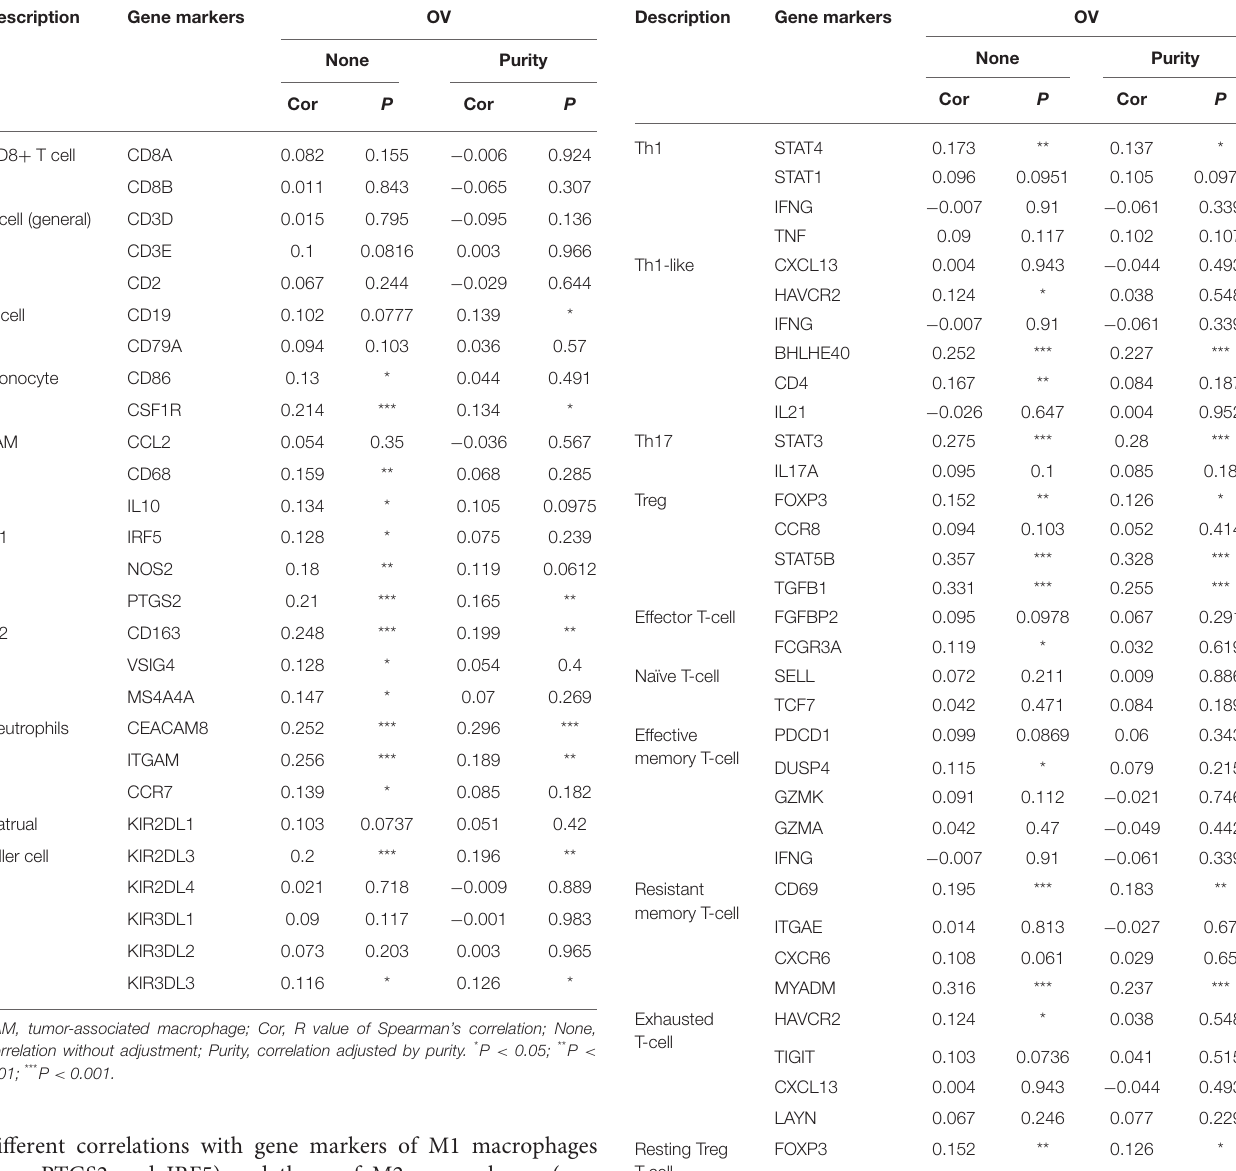
TABLE 5 | Correlations between PER1 and different T cell subgroups of